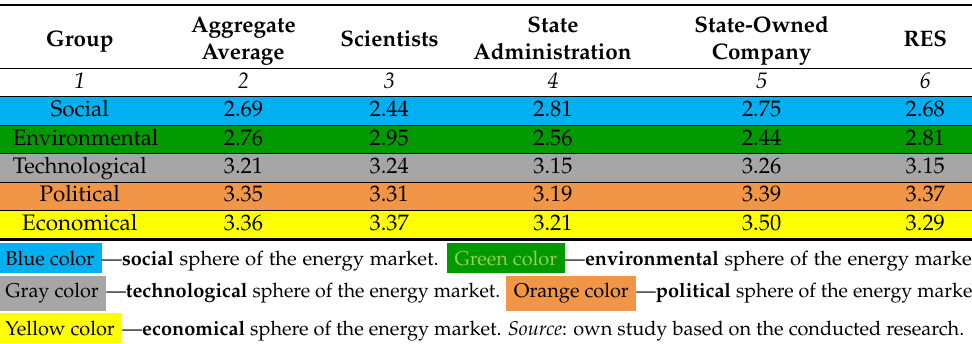
Table 7. Average weight attributed to a group of factors.